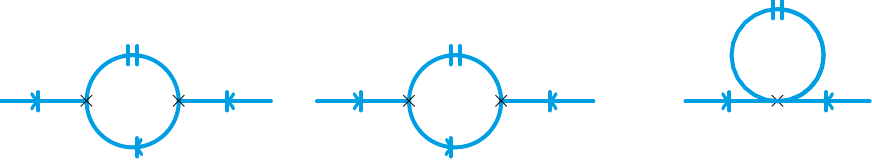
Figure 18. Renormalization of the Lindblad violating mass term in the average-di(cid:11)erence